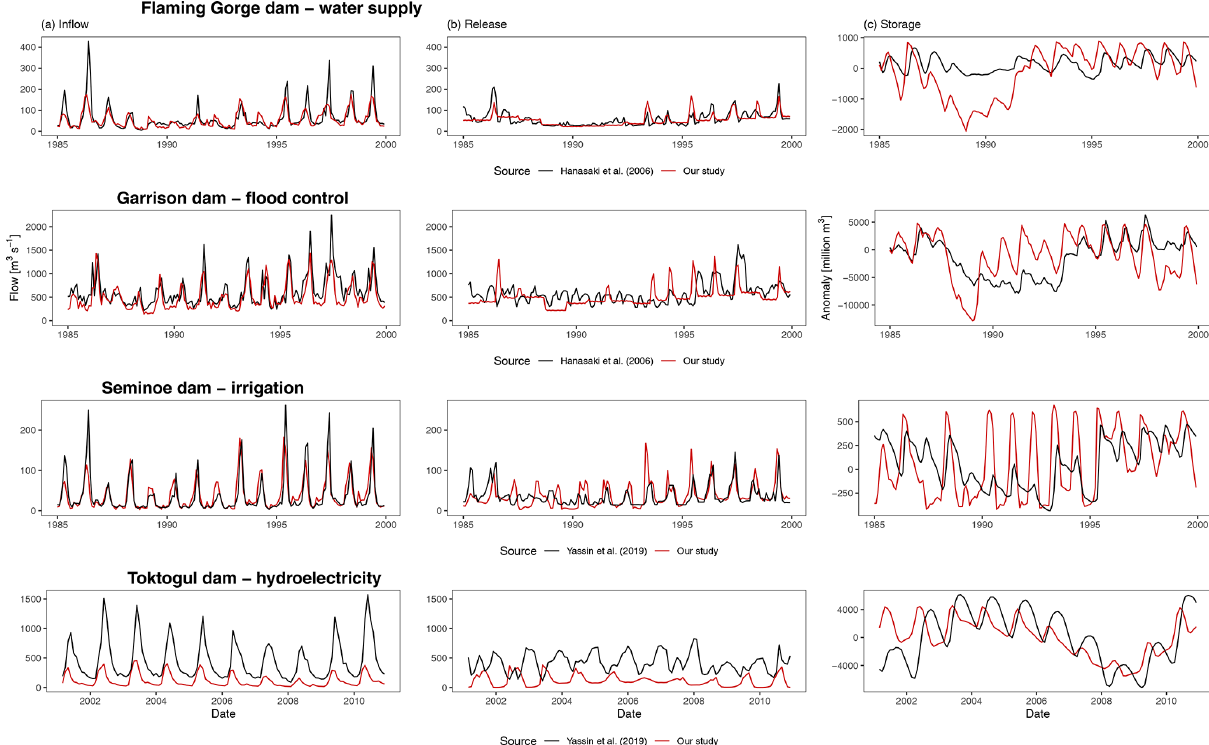
Figure 8. Comparison between the simulated reservoir operation and values observed by Hanasaki et al. (2006) and Yassin et al. (2019). Panels indicate the time series (a) inflow, (b) release, and (c) time series for anthropogenically impacted simulations (red) and observations